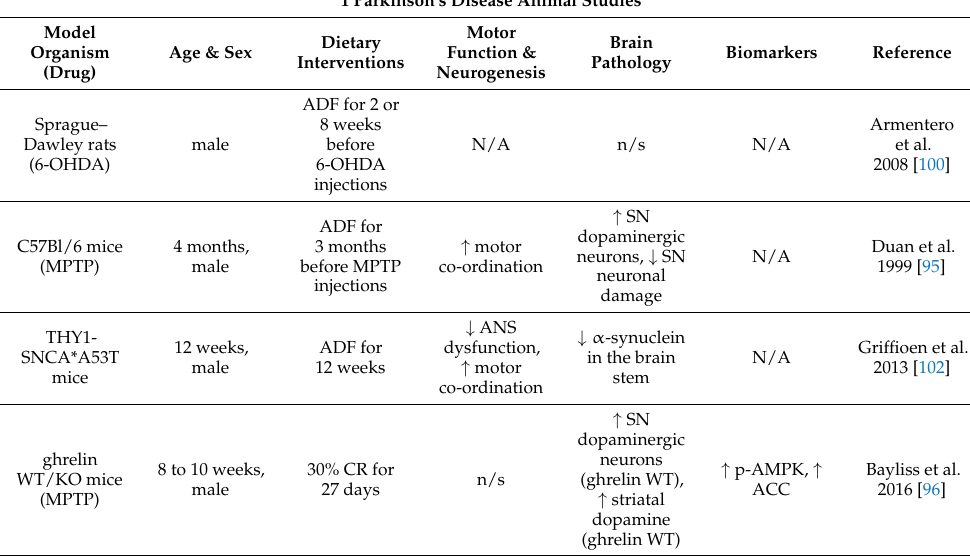
Table 2. All reviewed studies investigating the effects of DR in PD. N/A: relevant data not